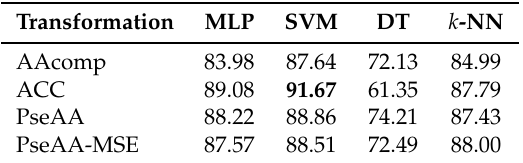
Table 3. Average classification accuracy (%) results of four classifiers using alignment-free representation datasets. AAcomp, amino acid composition; PseAA, pseudo-amino acid